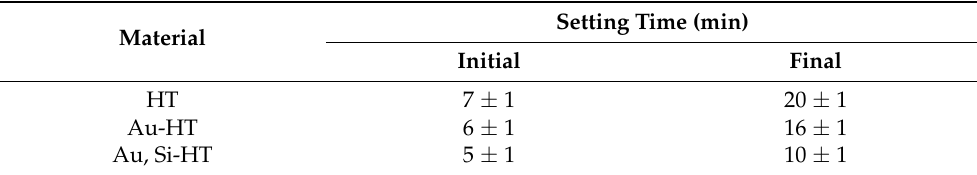
Table 3. The setting times of